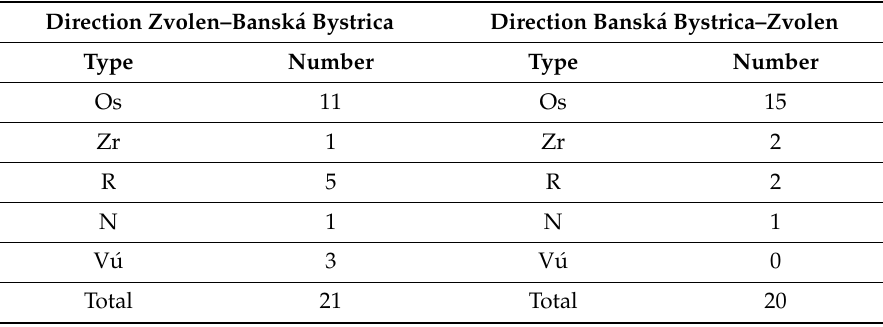
Table 1. Number and types of trains during the measurement of ZV1.